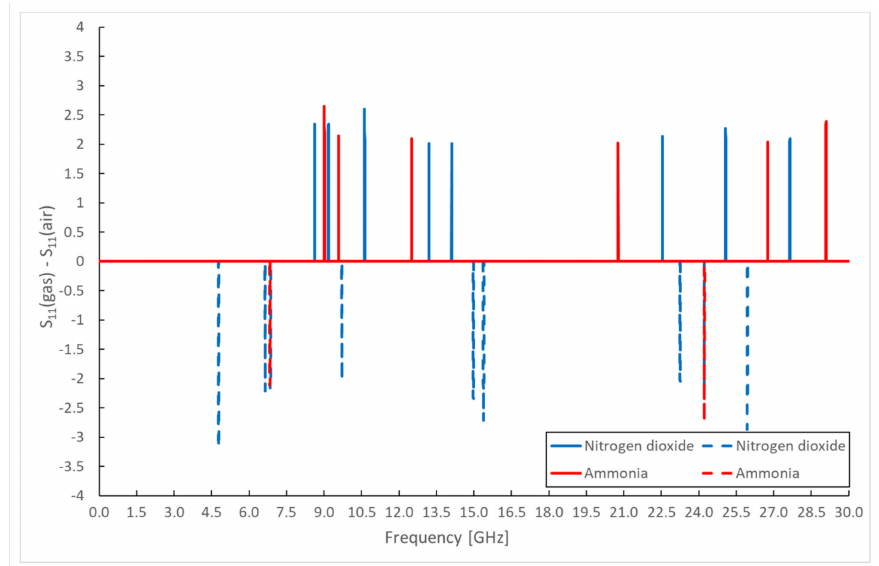
Figure 9. Differential spectrum of sensor response for monitored gases—S 11 parameter amplitude.